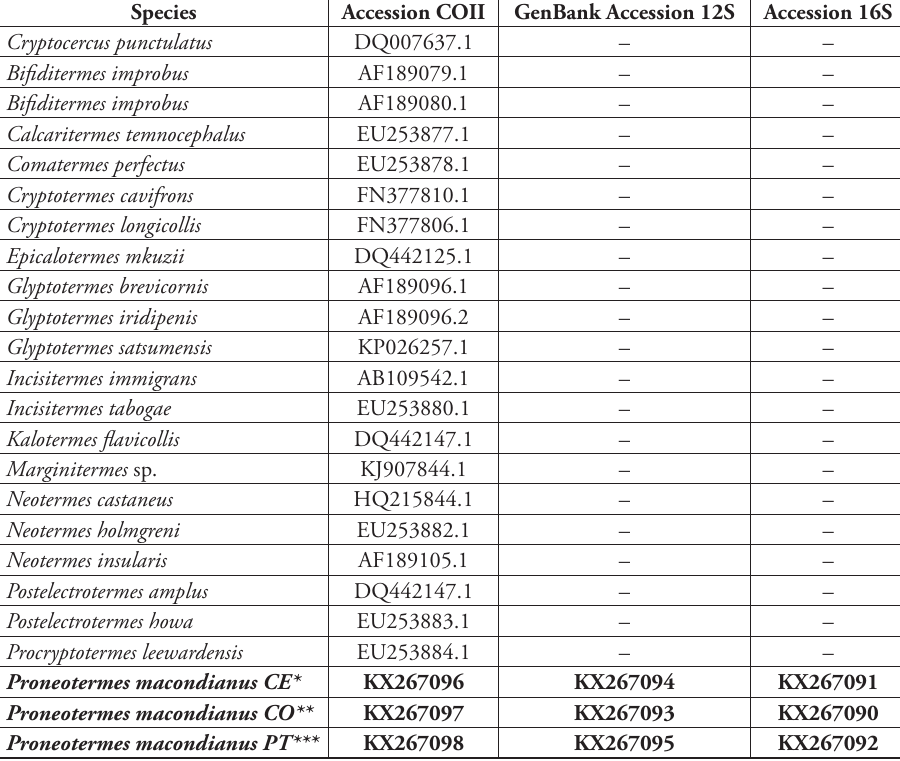
Table 1. GenBank accession numbers for COII, 12S and 16S